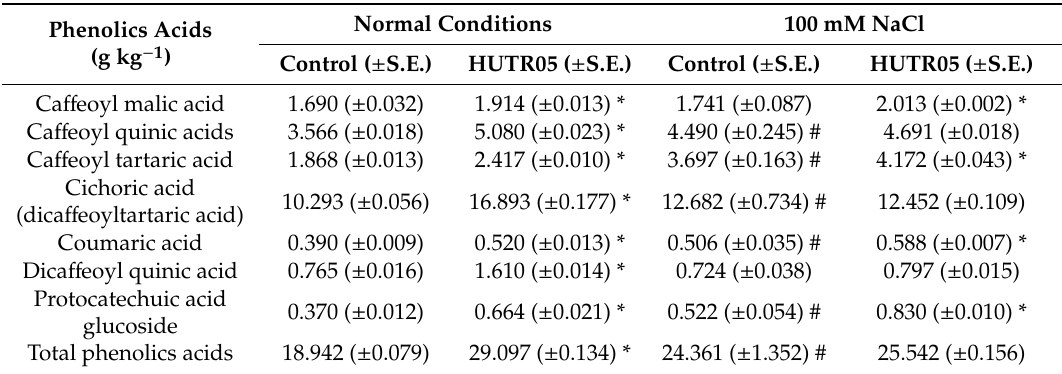
Table 3. Phenolic acid content (g kg − 1 ) of control lettuce plants and plants inoculated with Rhizobium laguerreae HUTR05.